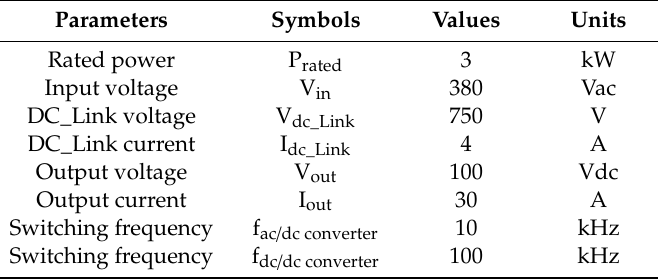
Table 1. The experimental parameters for ESS.